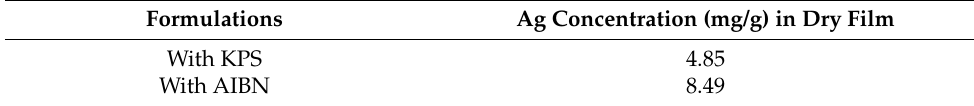
Table 4. AgNPs concentration in dry films determined by